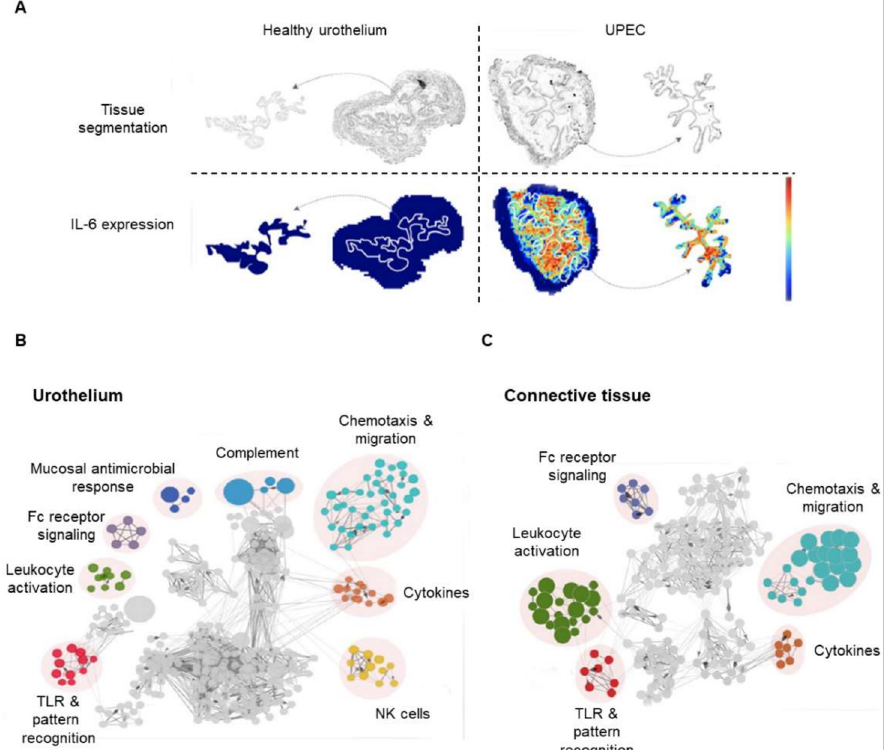
Figure 9. Schemes follow the same formatting. ( A ) Representative spatial distribution of IL-6 in healthy and infected (UPEC) bladder tissue by MALDI-MSI. ( B , C ) Enrichment functional analysis of the significantly upregulated proteins after infection in the urothelium by interaction networks ( B ) or the connective tissue ( C )